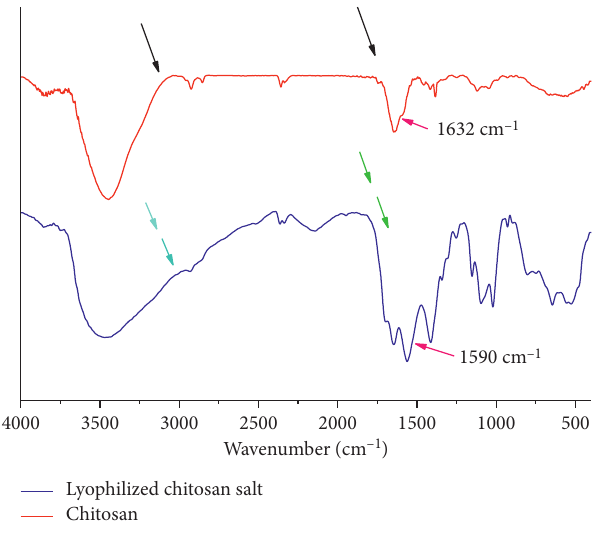
Figure 10: FTIR spectra of conventional chitosan and lyophilized chitosan